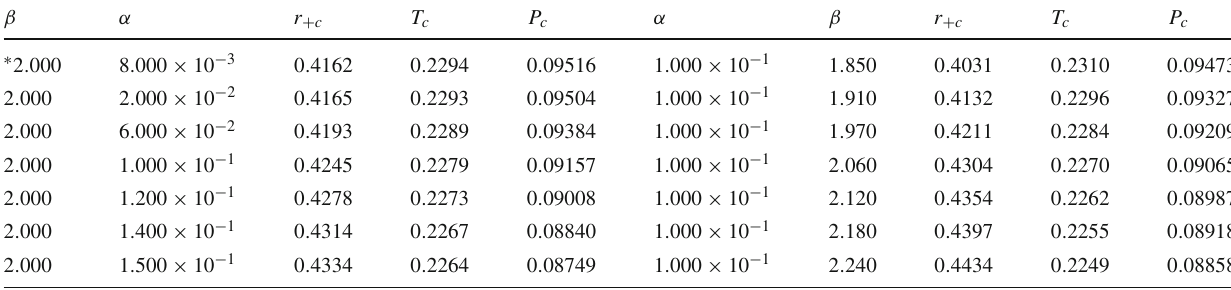
Fig. 3 P – T diagram. The shaded area illustrates the no black hole region and the right panel indicates a close-up of the RPT region. The blue and green curves indicate the coexistence lines of SBH and LBH, whereas the brown curve corresponds to the coexistence line of IBH Table 1 The critical values for RPT for q = 0 . 2 and b = 1. The row specified with ∗ shows the common RPT of black holes in which there is no zeroth order SBH–LBH phase transition below the critical